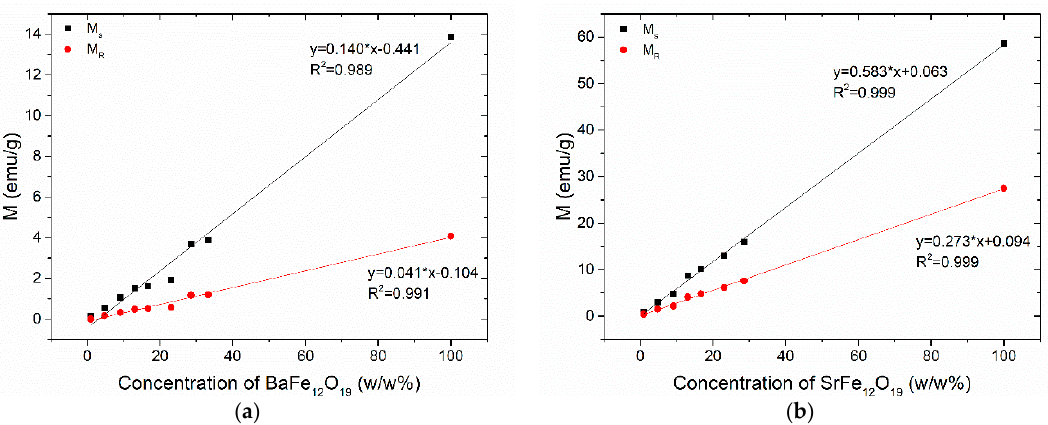
Figure 10. The variation of magnetization as a function of the magnetic filler concentration for the nanocomposites with: ( a ) BaFe 12 O 19 ; ( b ) SrFe 12 O 19 nanoparticles.